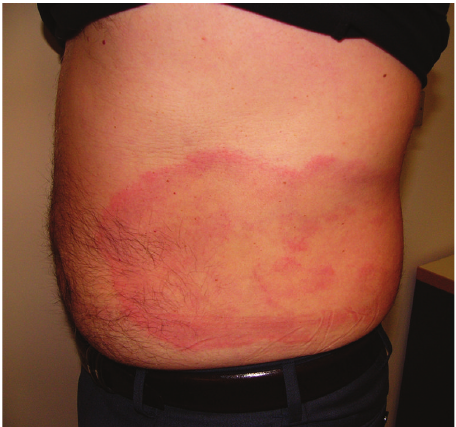
Figure 1: Erythema migrans.